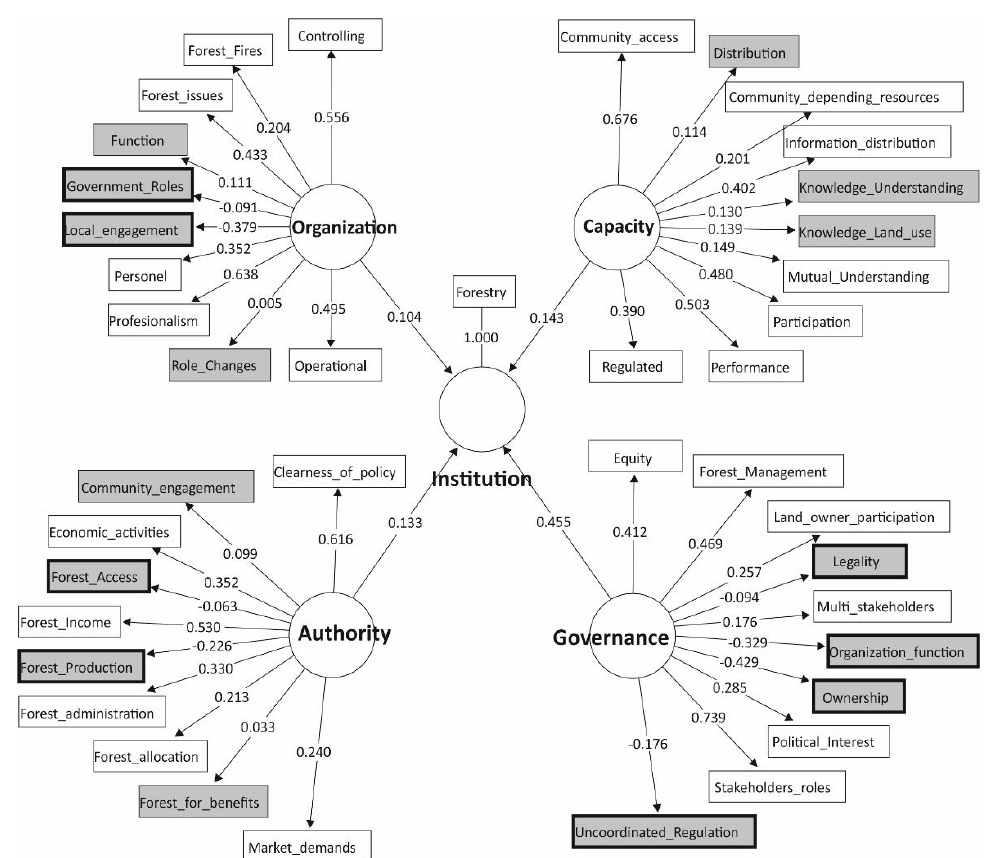
Figure 2. Development and measurement of indicators to strengthen institutions, 2020 (source: analysed and visualised with SmartPLS 2020).